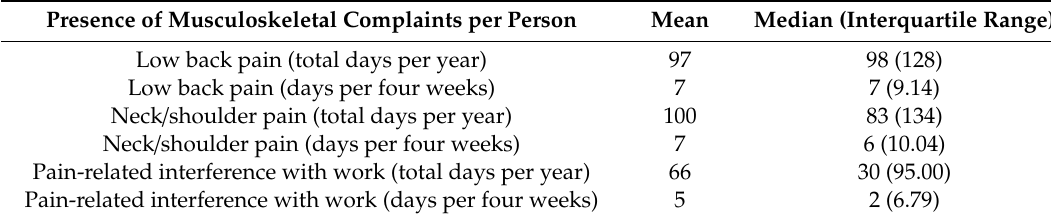
Table 2. Average duration of low back pain and neck / shoulder pain and pain-related interference with work (total days per four weeks and total days per year).